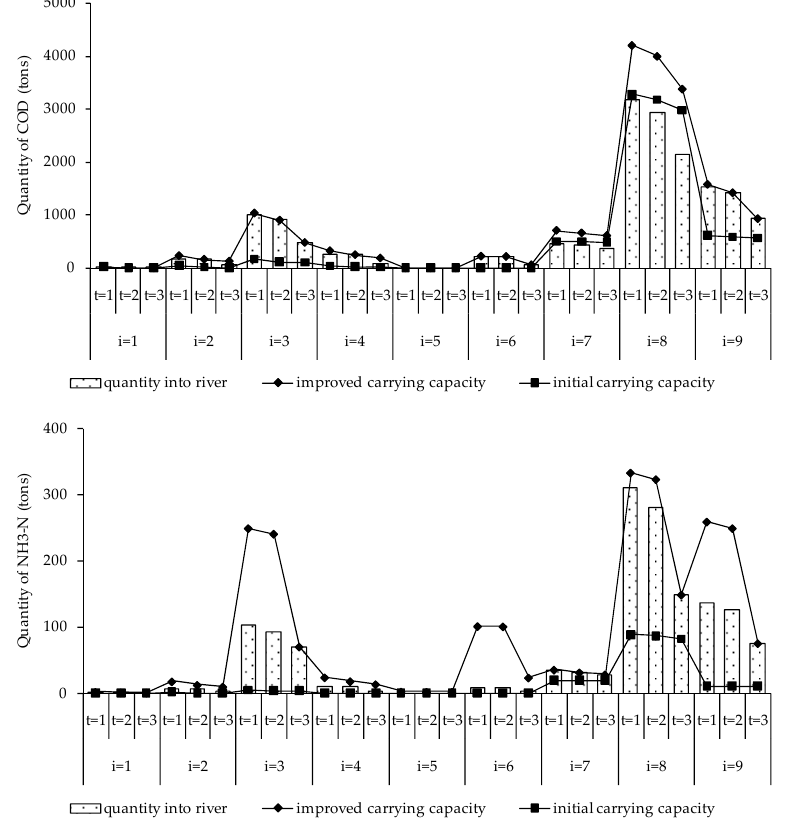
Figure 7. Environmental carrying capacities and pollutants into the Yitong River under the low flow level.